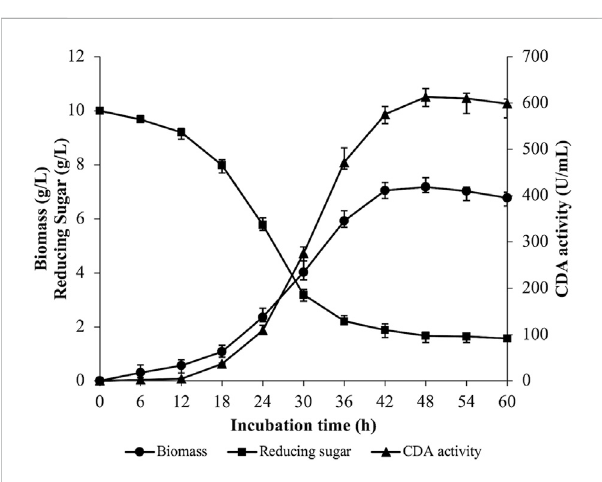
FIGURE 3 Time courses of biomass content, CDA activity, and reducing sugar in the fermentation broth. The strain ZWT-08 was cultured in a chitinmedium containing1%(m/V) glucose and1%(m/V) yeastextract at a pH of 6.0, a temperature of 37 ° C in 5 L fermenters. Error bars represent ± standard deviations ( n =